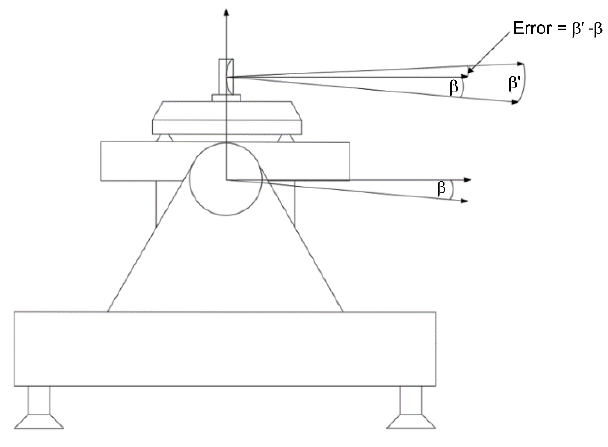
Figure 11. Schematic diagram of the experimental process.